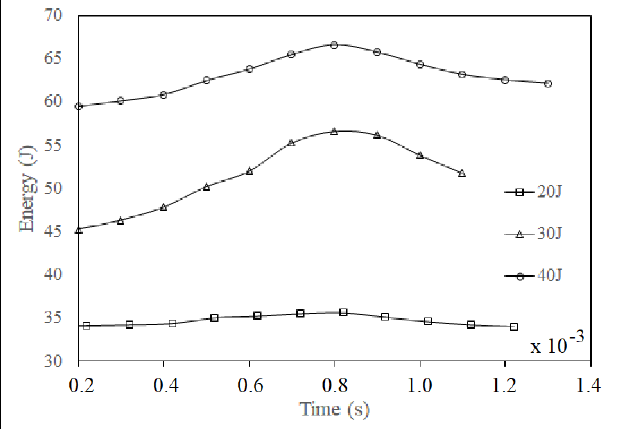
Figure 16. Energy absorbed by vertical energy impacts on unmodified panels.